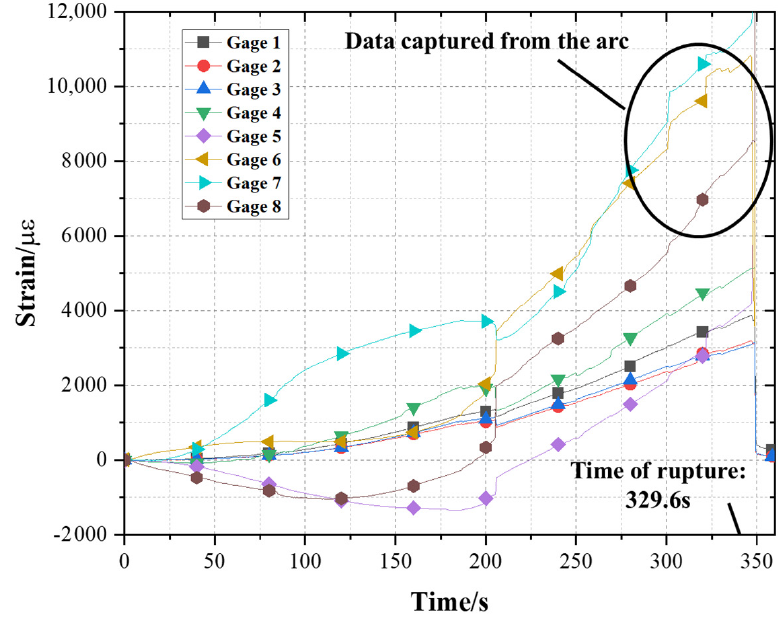
Figure 11. Strain curves of specimen A7 in eight positions of strain gages.